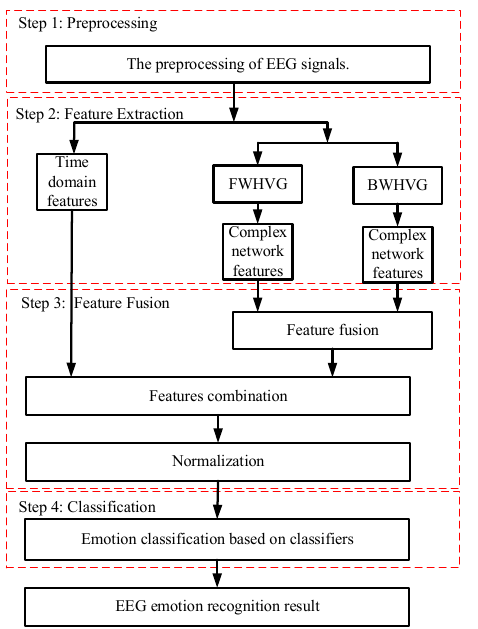
Figure 1. The block diagram of the proposed method for EEG emotion recognition.